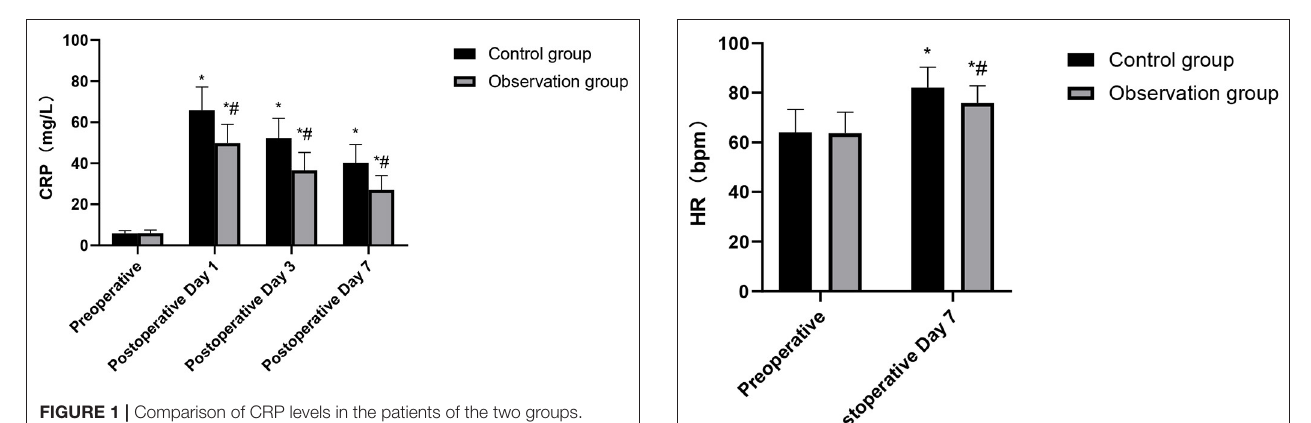
FIGURE 1 | Comparison of CRP levels in the patients of the two groups. Compared with preoperative, * p < 0.05. Compared with the control group, # p < 0.05.